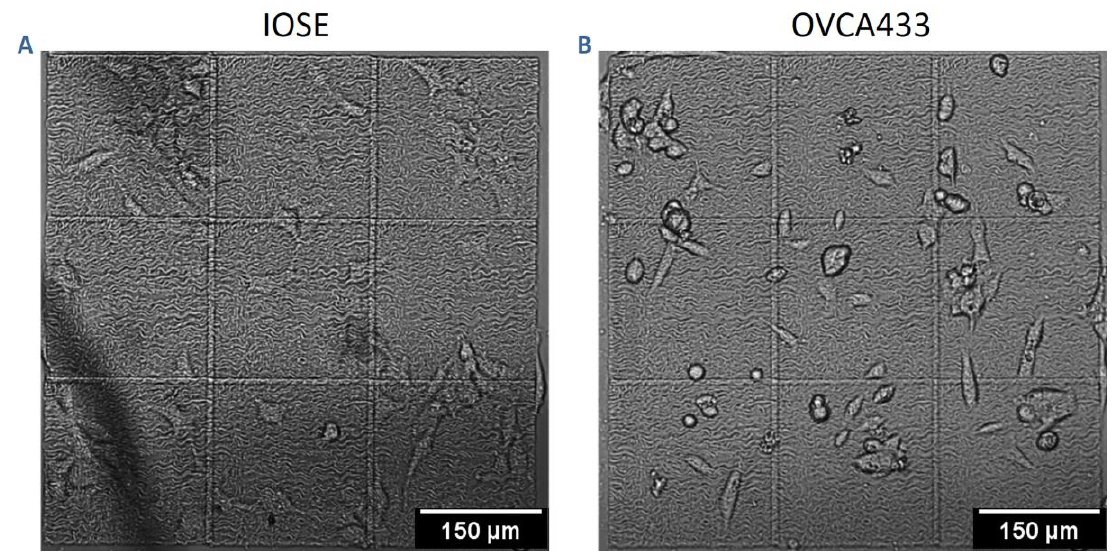
Figure 2. Phase-contrast images of IOSE ( A ) and OVCA433 ( B ) cells on a high-grade pattern. Scale bar = 150 µm.